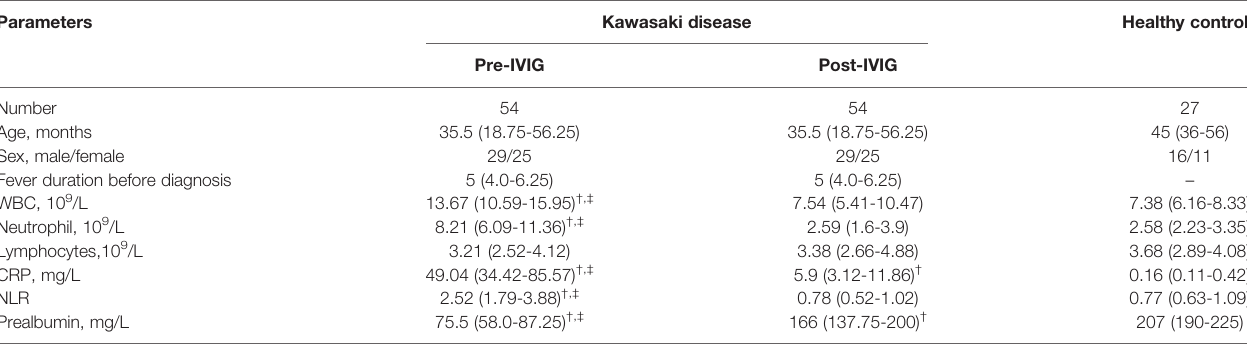
TABLE 1 | Characteristics of the study